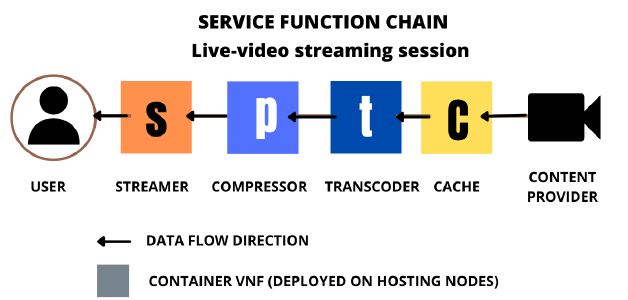
Figure 1. The assumed Service Function Chain composition for every Live-Video Streaming session request. We assume that every incoming session needs for a streamer, a compressor a transcoder and a cache VNF modules. We assume container based virtualization of a